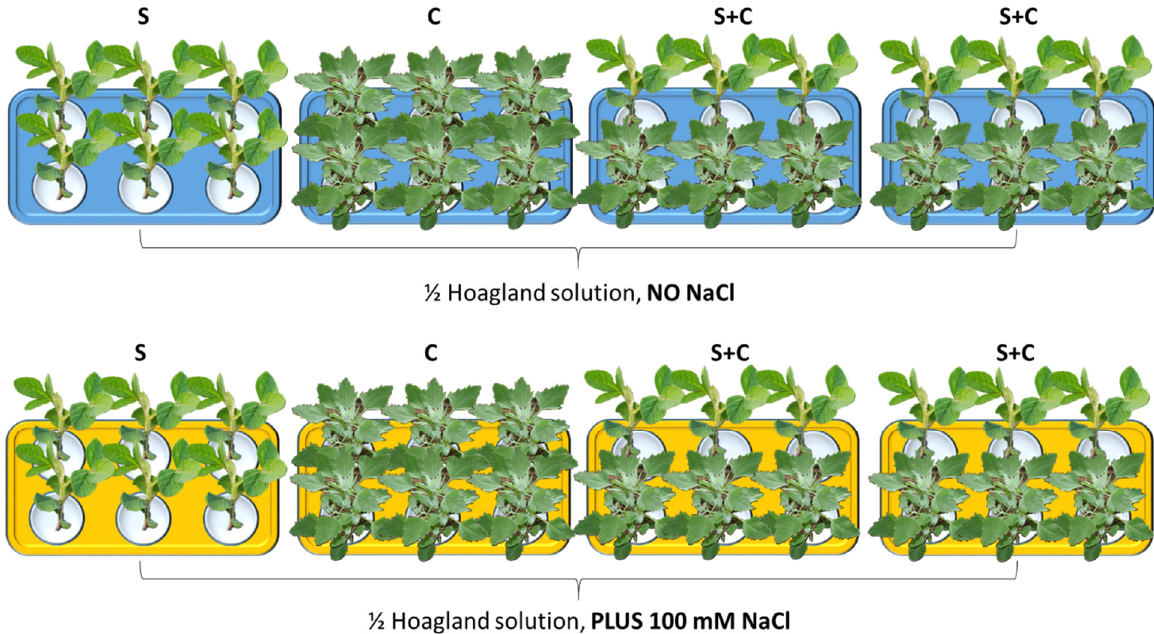
Figure 1. Experimental design of the hydroponic set-up. S = Soybean; C = C. album .